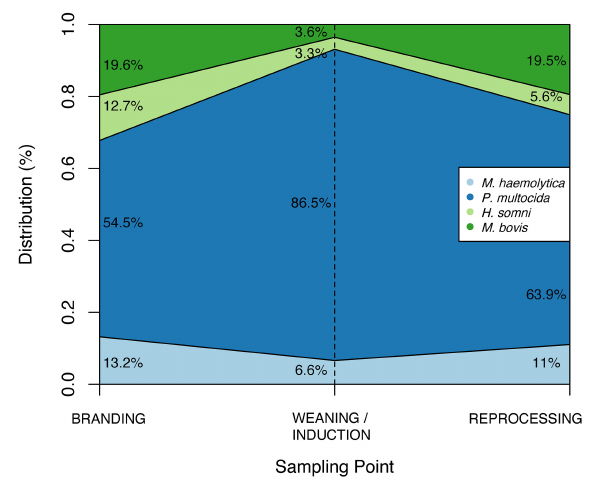
FIGURE 1 | Distribution of respiratory pathogens according to sample